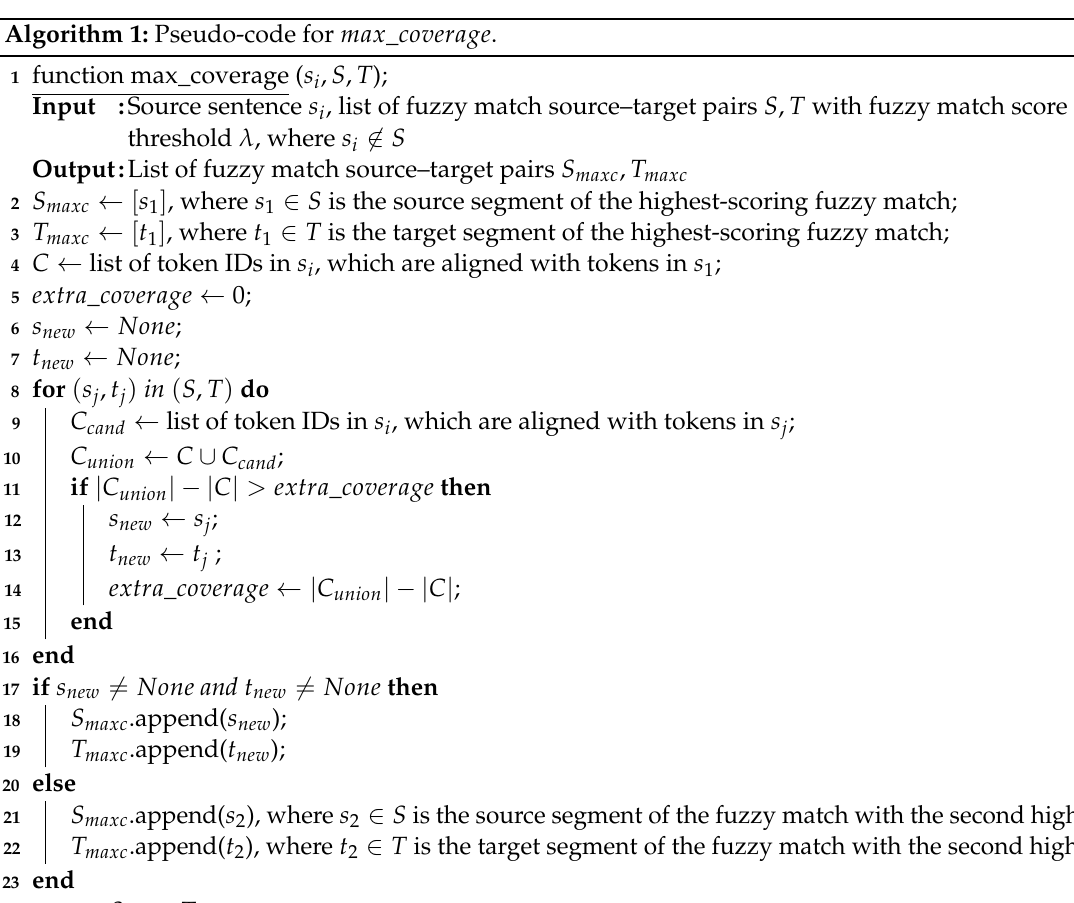
Algorithm 1: Pseudo-code for max _ coverage